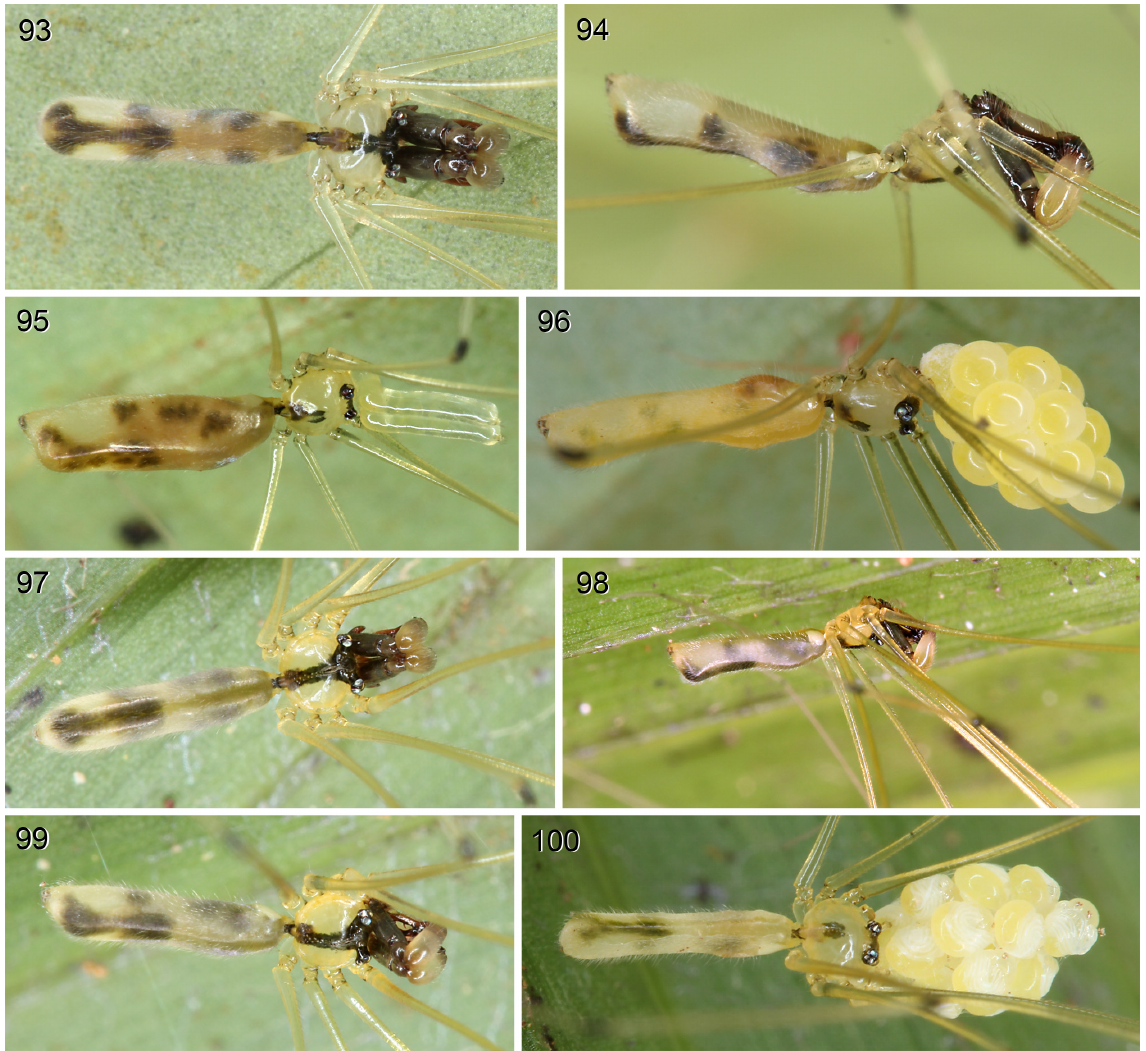
Figs 93–100. Live specimens. 93–96 . Pholcus tambunan Huber sp. nov., Crocker Range, ♂,